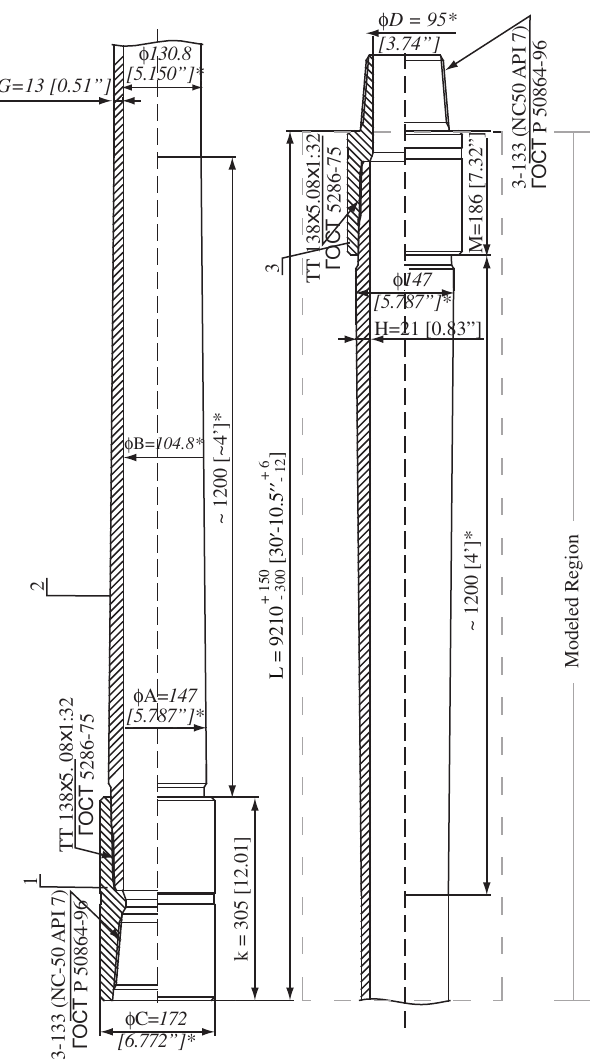
Figure 2. Sketch showing drill pipe nominal